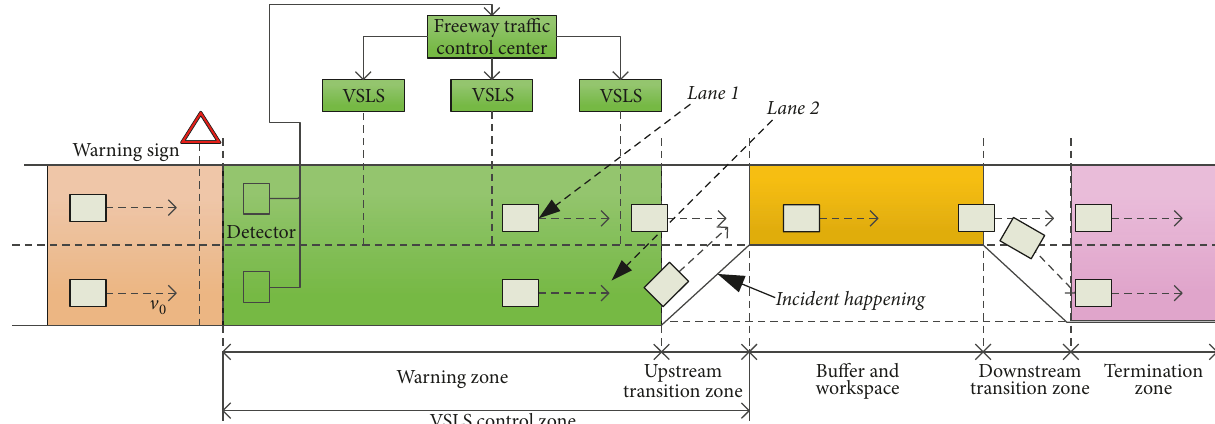
Figure 1: Composition of freeway work